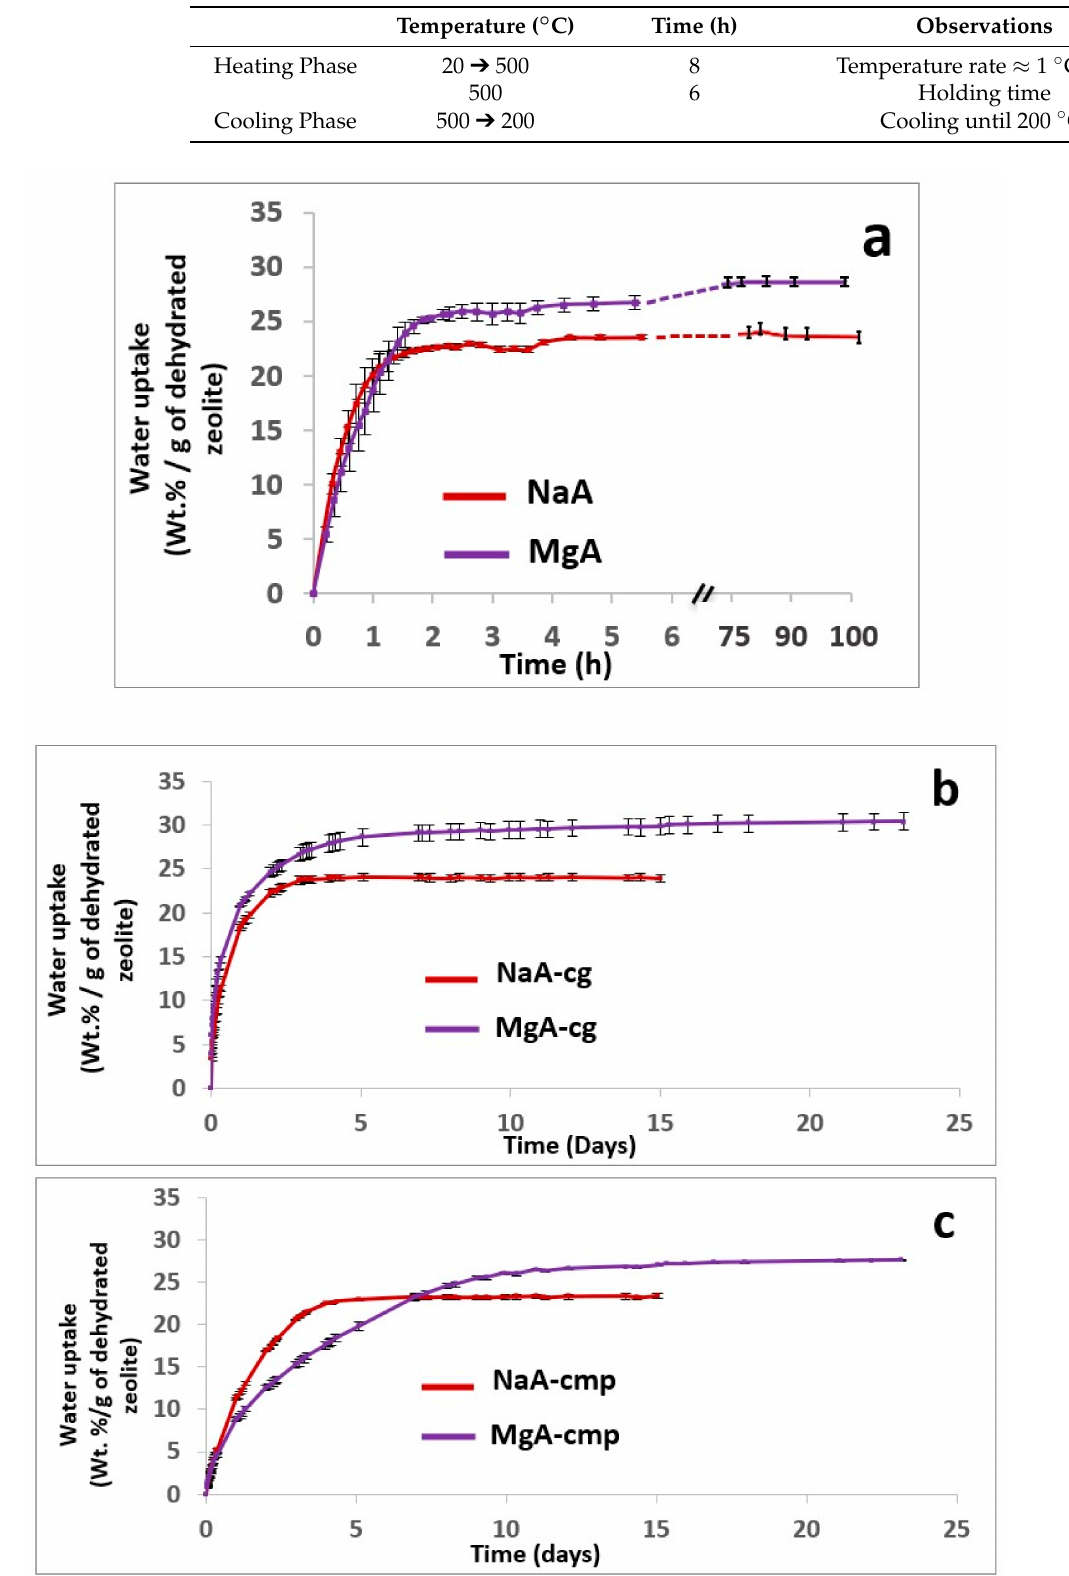
Figure 8. Water adsorption kinetics at 25 ◦ C and Patm of ( a ) the LTA-type zeolite (NaA) and (MgA) and their associated composites forms, ( b ) NaA-cg and MgA-cg samples, and ( c ) NaA-cmp and MgA-cmp